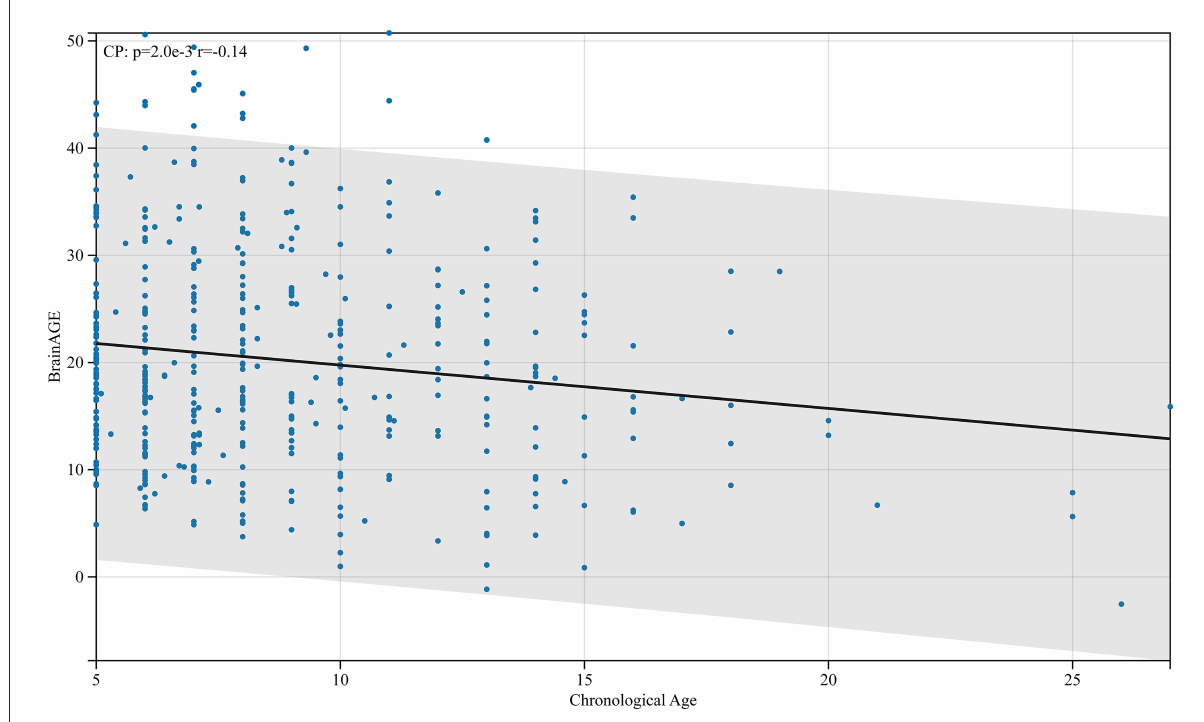
FIGURE8 Relationship between BrainAGE difference and physiological age in patients with cerebral palsy. As shown in the figure, the BrainAGE of patients with CP negatively correlates with their physiological age ( r = − 0.14, p <